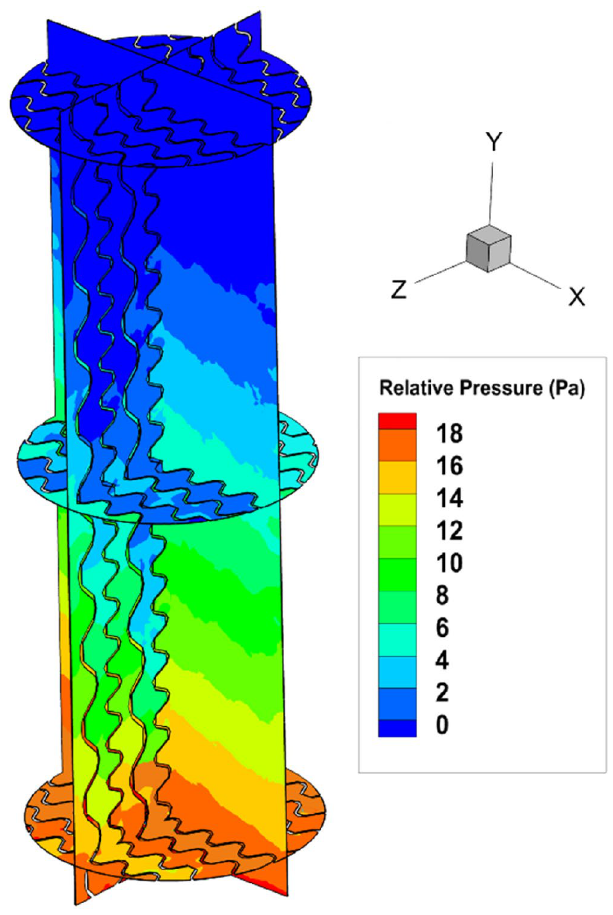
Figure 4. The pressure profile at the inside of the PACK-1300XY (F-factor = 1.2 Pa 0.5 , liquid flow rate = 7.5 m 3 / m 2 h).